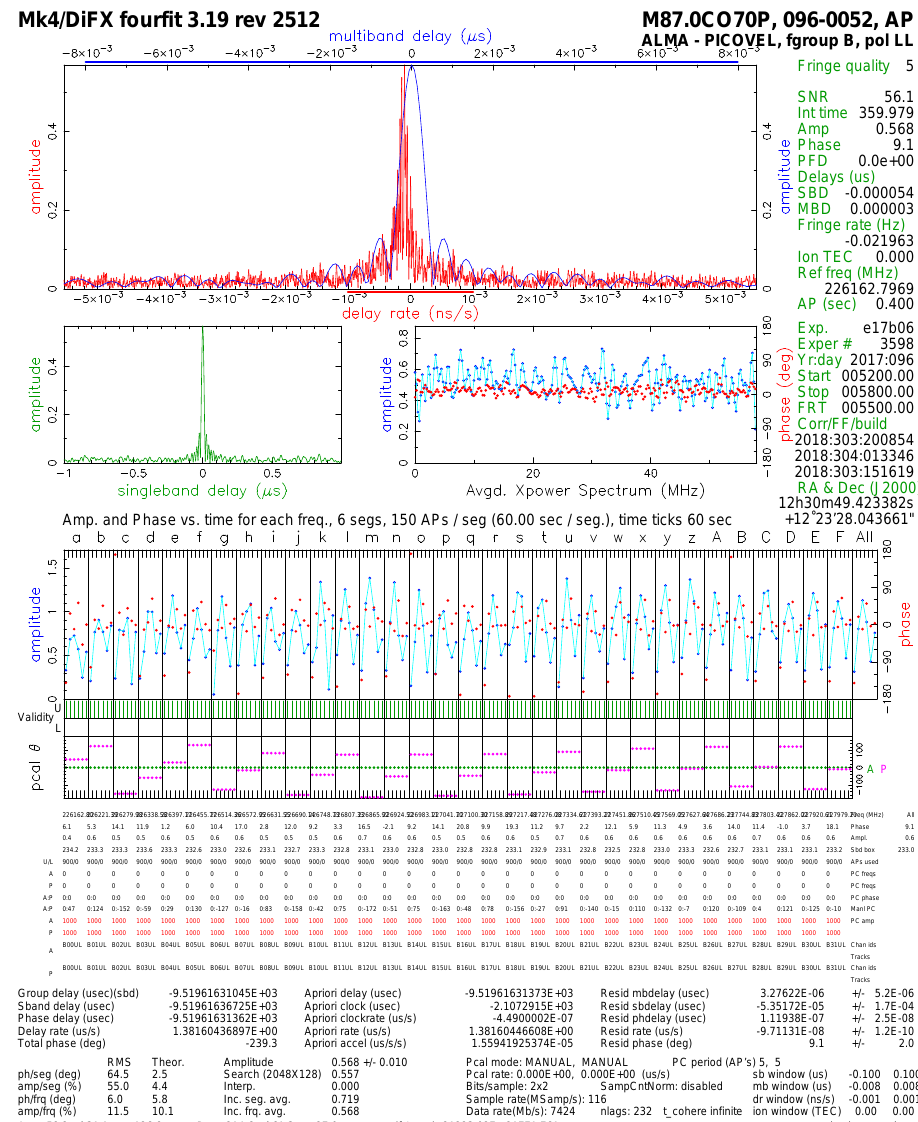
Figure 1. An example fringe plot from the 2017 EHT observations of